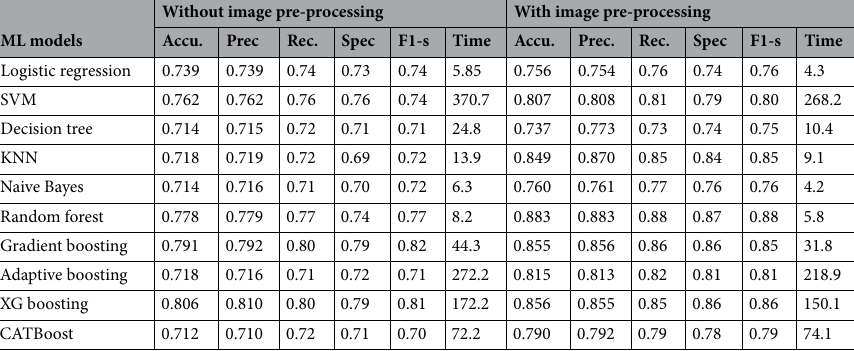
Table 1. Performance analysis of test data using traditional machine learning technique with and without image pre-processing (Technique